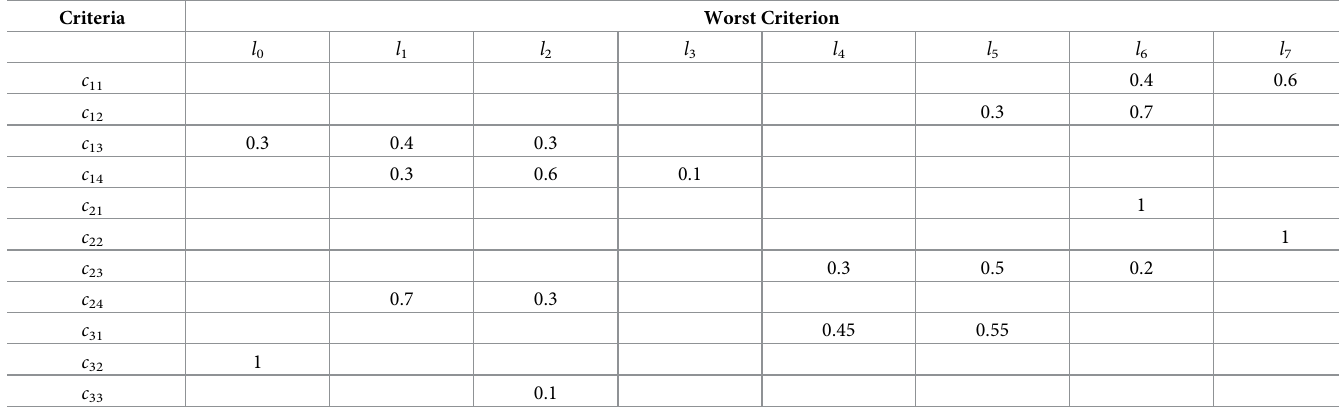
Table 7. The linguistic label for fuzzy preferences of all criteria over the worst criterion. Criteria